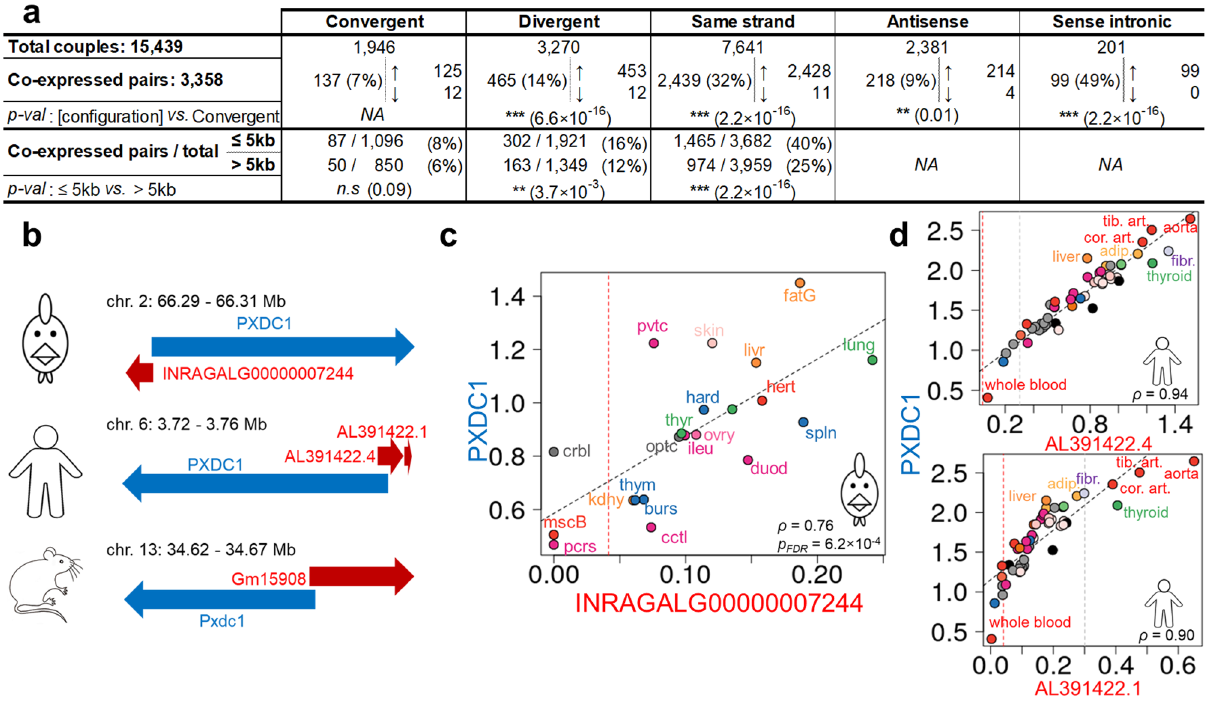
Figure 3. Classification and co-expression using the extended catalogue. ( a ) Overview of the correlations between the LNC and the PCG genes from all the expressed pairs, according to the different classes and the distance between the two genes of the pair. “ p-val: [configuration] vs. Convergent ” is the p-value of a Fisher test for the enrichment in significantly correlated pairs from the configuration in column versus the convergent configuration. “ p-val: ≤ 5 kb vs. > 5 kb ”is the p-value of a Fisher test for the enrichment of significantly correlated pairs at less than 5 kb versus more than 5 kb. (*: p-val ≤ 0.05; **: p-val ≤ 0.01; ***: p-val ≤ 0.001; n.s : not significant). ( b ) Conservation of the genomic configuration of PXDC1 and its closest LNC in chicken (top), human (middle) and mouse (bottom). In human, two close LNC are present. ( c ) Expression correlation in log 10 (TPM + 1) between INRAGALG00000007244 and PXDC1 across 21 tissues of the 21 T dataset. Tissues abbreviations are the same as in Fig. 2. ( d ) Conservation of the correlation between PXDC1 and its closest LNC in human in log 10 (TPM + 1). NA not